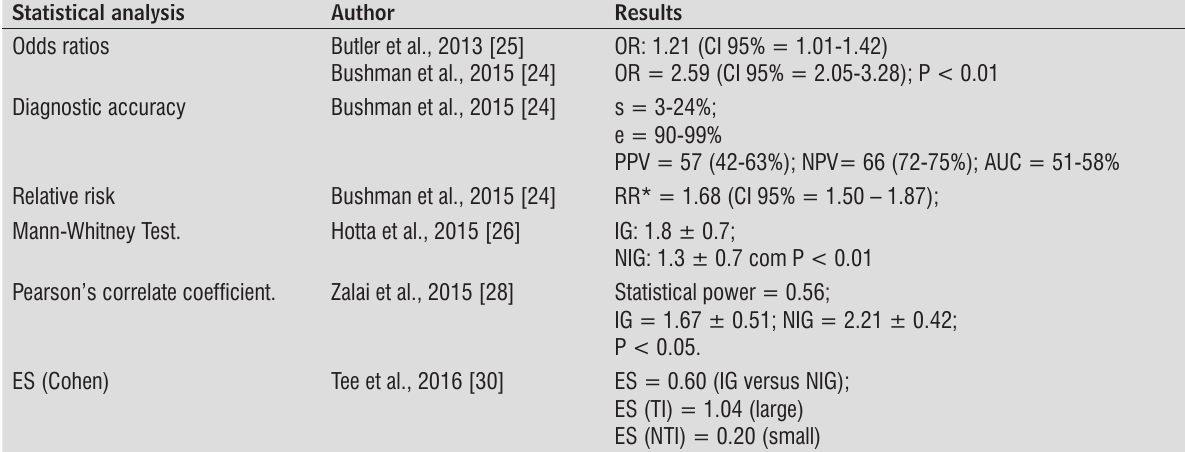
Table 2 - Statistical Analysis of the included studies.